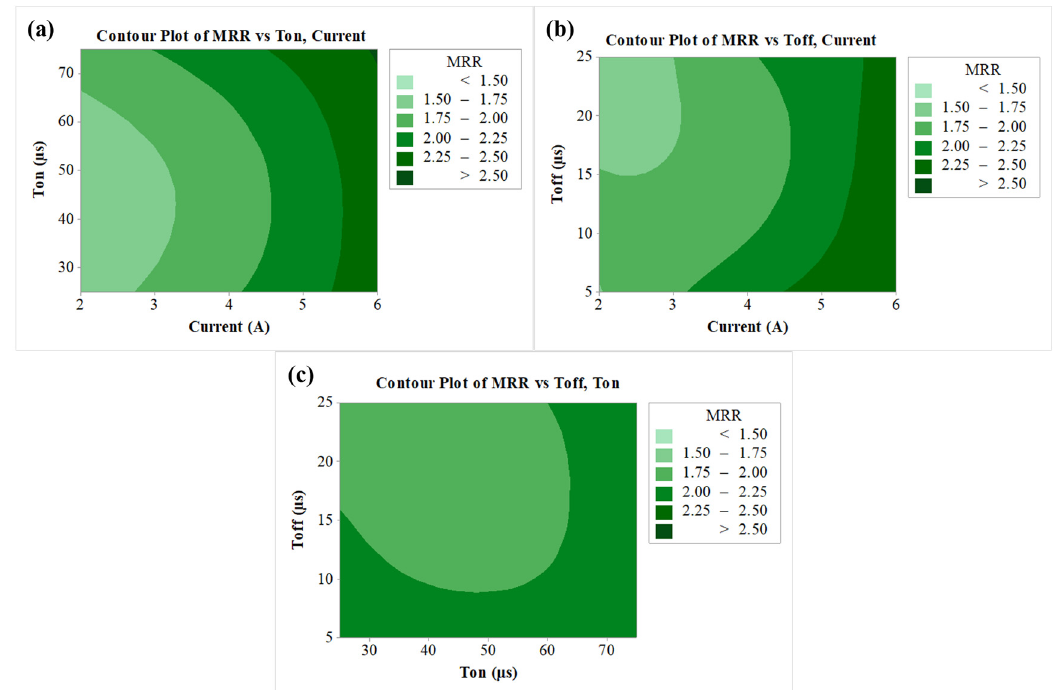
Figure 5. Contour plots for ( a ) MRR vs T on , current, ( b ) MRR vs T off , current, ( c ) MRR vs T off , T on.